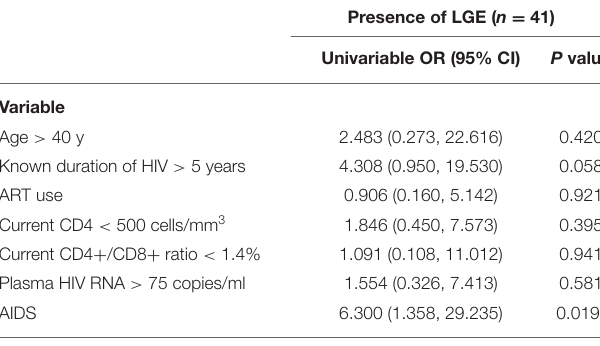
TABLE 3 | Association of myocardial fibrosis and HIV related clinical